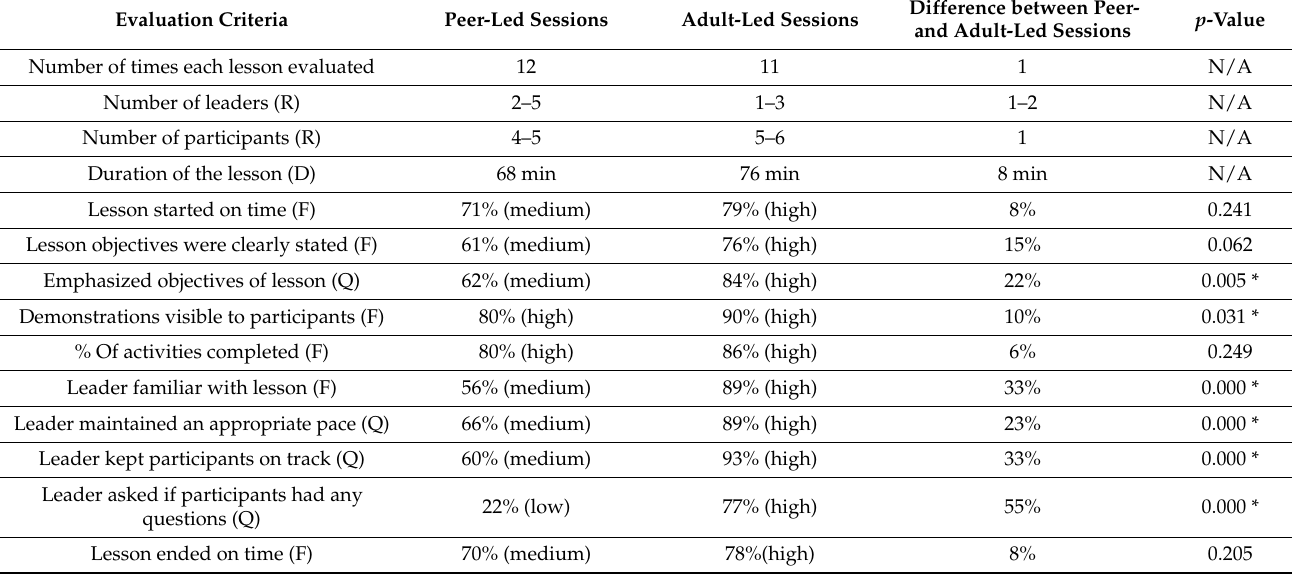
Table 3. Comparison of process evaluation between peer and adult